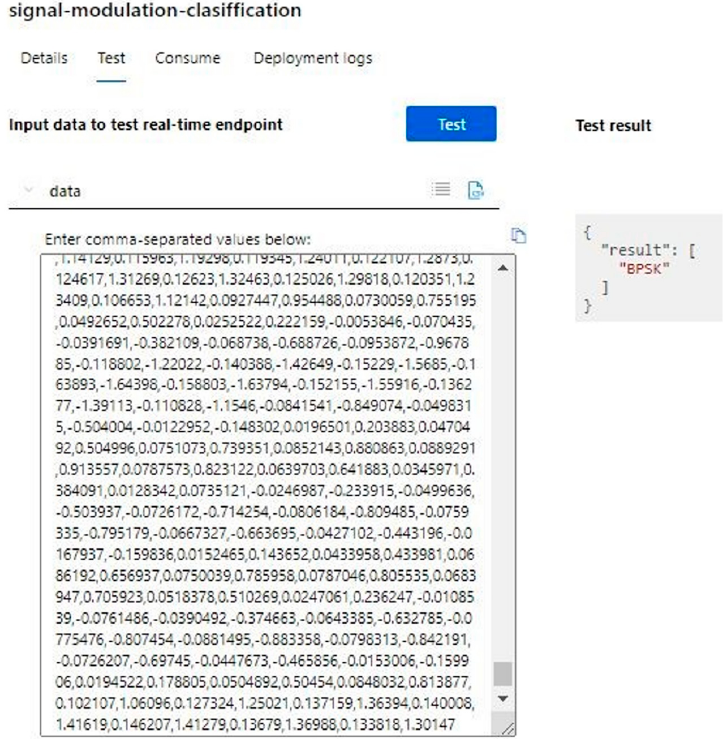
Figure 3. Testing for BPSK signal.